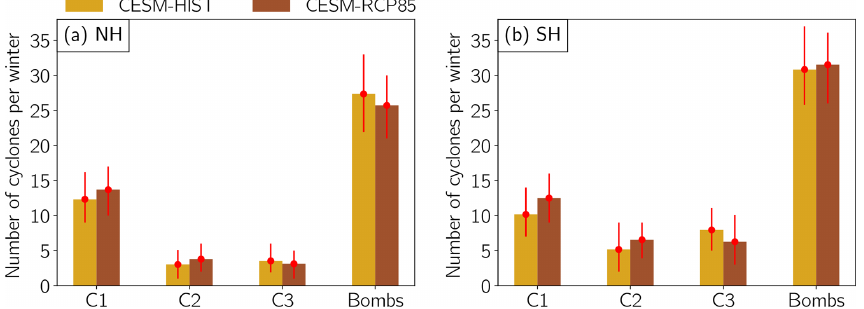
Figure 5. Number of C1, C2, C3, and bomb cyclones per winter in CESM-HIST and CESM-RCP85 in the (a) NH and (b) SH. The red circles denote the mean number over the 50 simulated years, and the lower and upper ends of the red vertical lines denote the 10th and 90th percentiles, respectively. Table 2. Mean latitude of C1 cyclones at the beginning of their strongest deepening in the Northern Hemisphere (NH), Southern Hemisphere (SH), North Atlantic (NATL), North Pacific (NPAC), South Atlantic (SATL), and South Pacific (SPAC). Mean